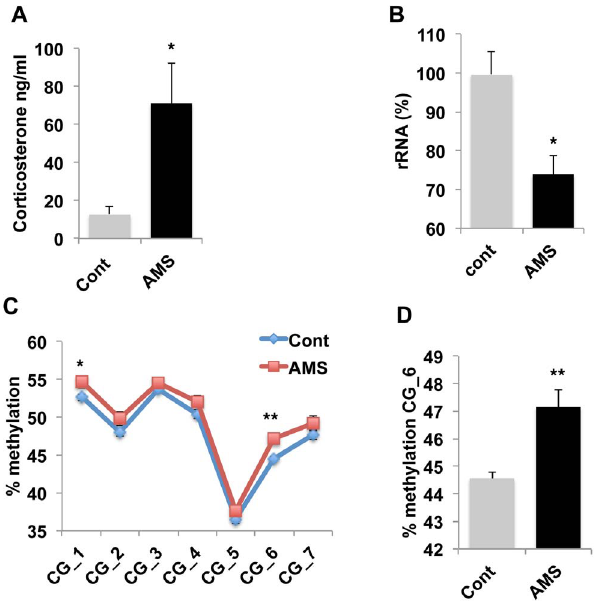
Fig. 6. Exposure to 3 hr acute maternal separation (AMS) in 14-day old pups reduces rRNA levels and increases DNA methylation at CG_6. Three hours of maternal separation in 14-day old pups increased plasma levels of corticosterone (A), reduced rRNA levels in the hippocampus (B), and increased DNA methylation at the rDNA promoter (C), most notably CG_6 site (D). Unpaired Student t tests (A, B, D), Repeated measures ANOVA followed by simple-effect analysis (C). Error bars represent mean ¡ SEM, *p , 0.05, **p , 0.01.